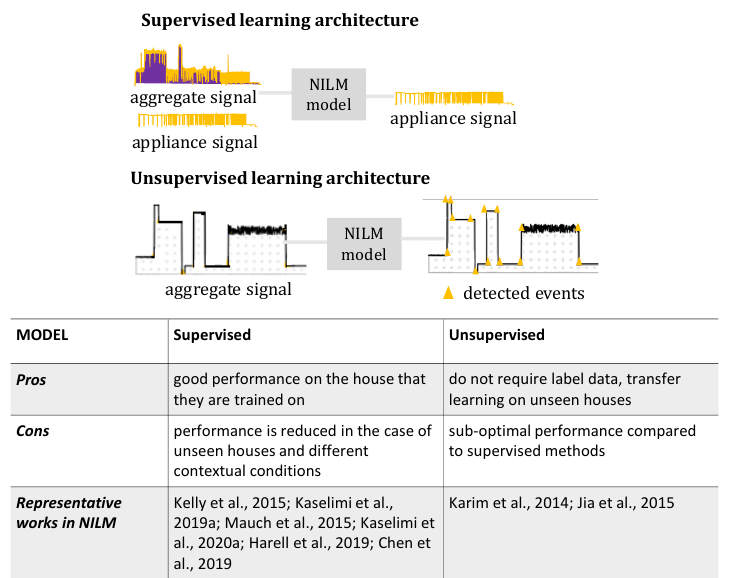
Figure 5. Supervised versus unsupervised NILM algorithms